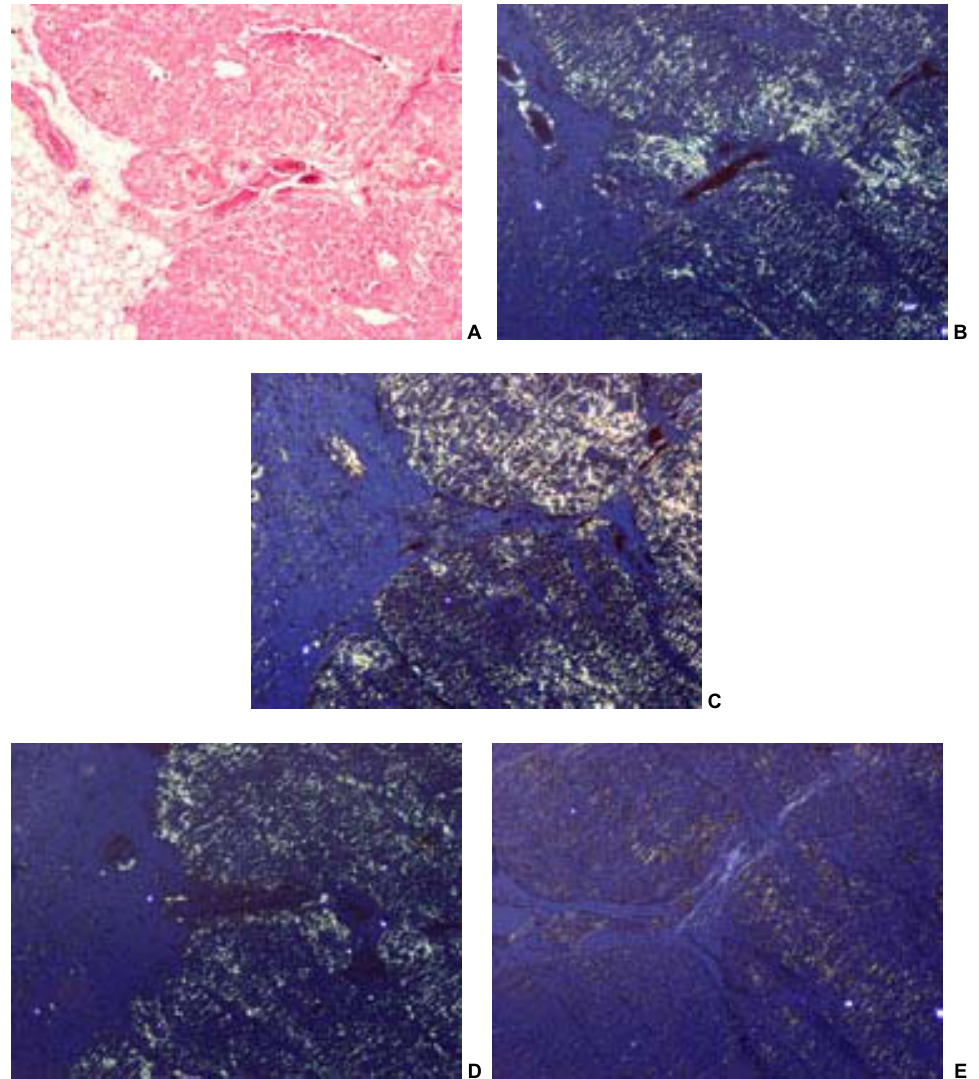
FIGURE 2A–E. Heart, subepicardial region. Systemic AL- κ amyloidosis. (A) Hematoxylin and Eosin. × 40. (B) Same as Fig. 2A. Congo red staining according to Romhányi, without alcoholic differentiation, covered with gum arabic, viewed under polarized light. × 40. (C) Same as Fig. 2A. Performate pretreatment (for 1 sec), Congo red staining, viewed under polarized light. Systemic AL amyloid deposits are resistant to performate pretreatment ( for 1–5 sec). × 40. (D) Same as Fig. 2A. KMnO 4 oxidation (for 1 min). Systemic AL amyloid deposits are resistant to KMnO 4 oxidation (for 30 sec – 3 min), resistant / sensitive ( for 5 min), and sensitive (for 10 min). × 40. (E) Same as Fig. 2A. KMnO 4 oxidation (for 5 min). Systemic AL amyloid deposits are resistant / sensitive to KMnO 4 oxidation (for 5 min). ×